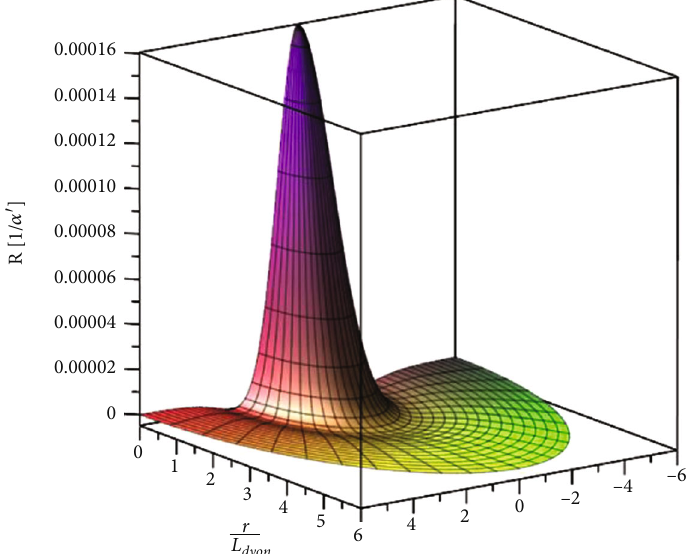
Figure 2: Scalar curvature: depicted in (a) and (b) are the scalar curvatures of a magnetic monopole and dyon, each without spin. In each fi gure, the scalar curvature, R , in units of 1/ α ′ , is plotted as a function of the dimensionless, spherical coordinates r / L the gluon M = ð M /2 Þ . The Yang-Mills coupling constant g gluon P